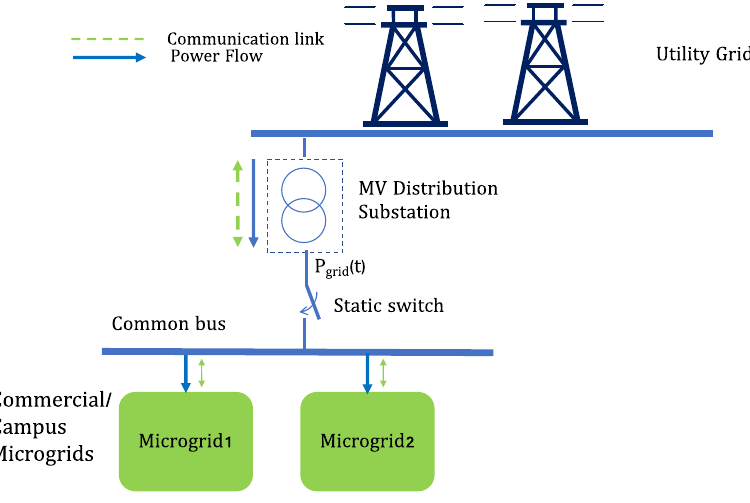
Figure 6. Basic layout for a system with two Grids.